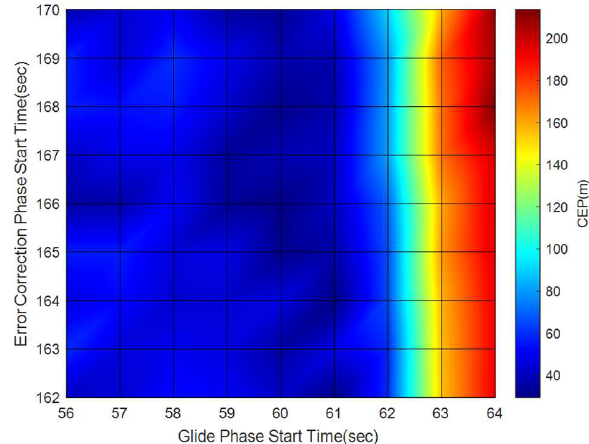
Figure 16. Guidance Phase Start Time Optimization.